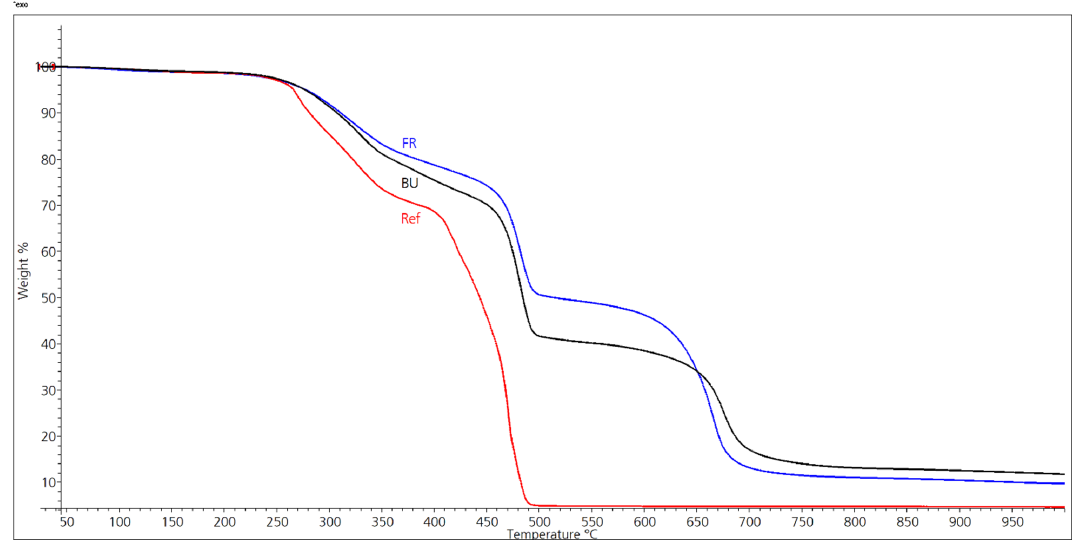
Figure 15. TGA of compounds with Budit 669 (BU), FR CROS 490 (FR), and without fire-retardant (Ref); composition of compounds shown in Materials and Methods.